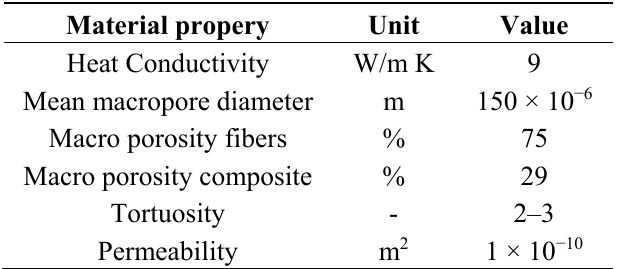
Table 1. Material properties of composite material.